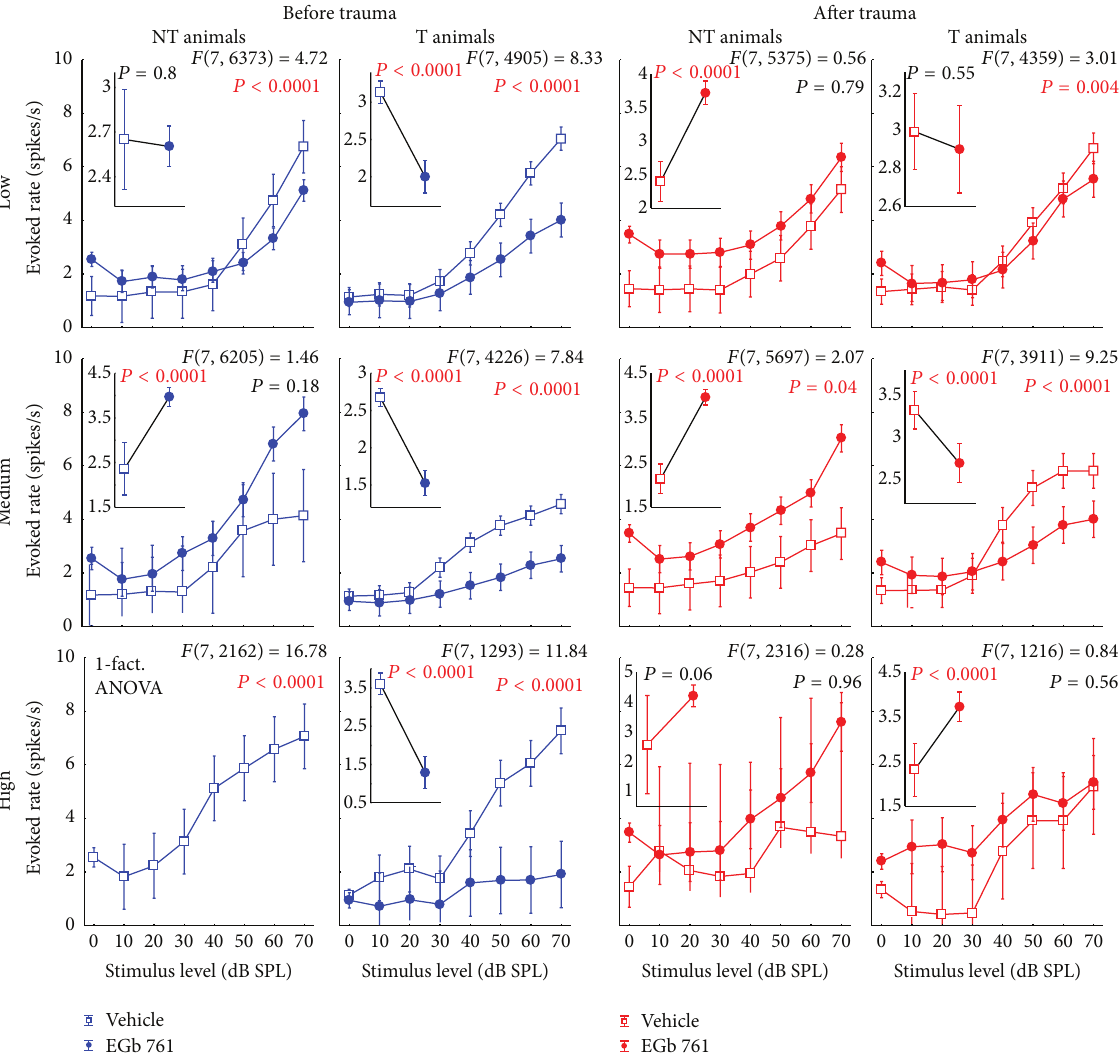
Figure 17: Replotted data of Figure 10, grouped according to the time of measurement (before versus after trauma) to allow for an easier comparison of vehicle versus EGB 761 treated